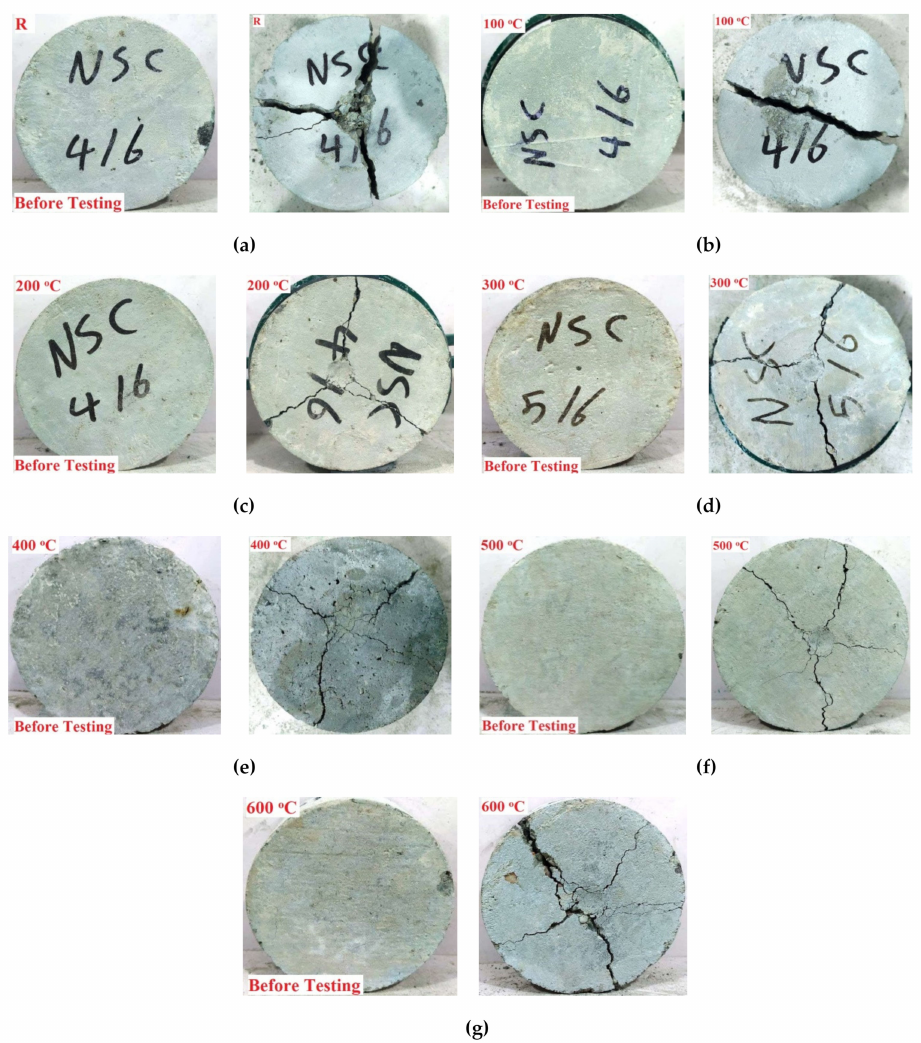
Figure 14. Failure patterns of the impact disc specimens at different temperatures ( a ) ambient temperature; ( b ): 100 ◦ C; ( c ): 200 ◦ C; ( d ) 300 ◦ C; ( e ) 400 ◦ C; ( f ) 500 ◦ C; ( g ): 600 ◦